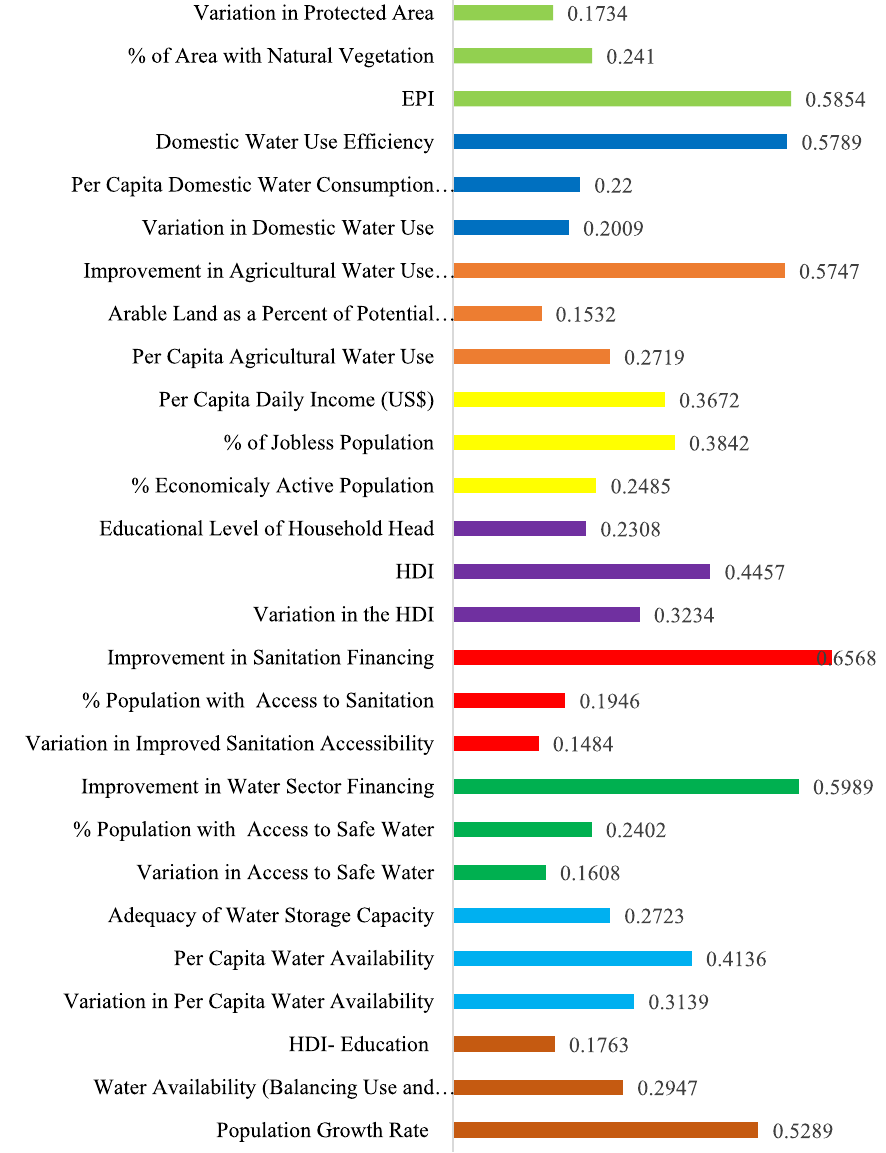
Fig. 3 eWPI parameters’ weights in